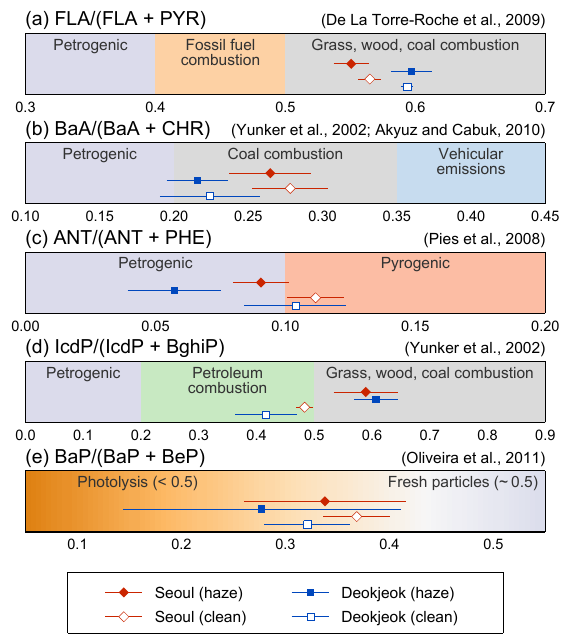
Figure 5. Various PAH ratios of (a) FLA / (FLA + PYR),